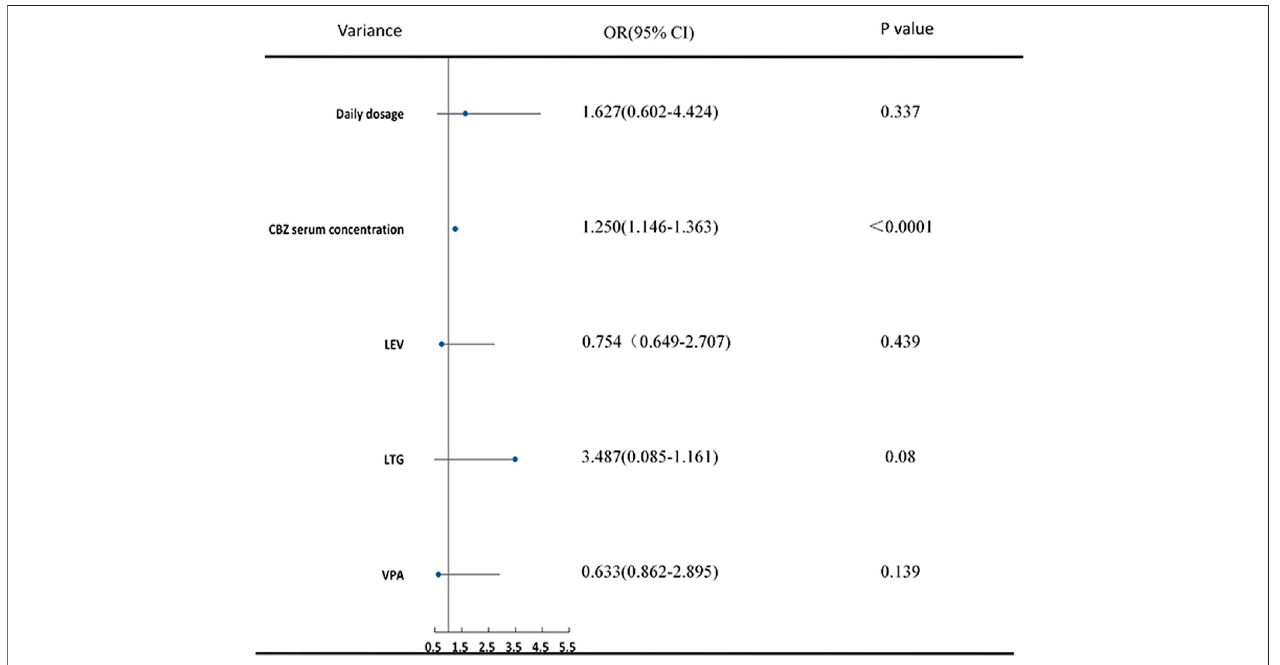
FIGURE 3 | Ordinal logistic regression analysis of predictors of CBZ ef fi cacy.